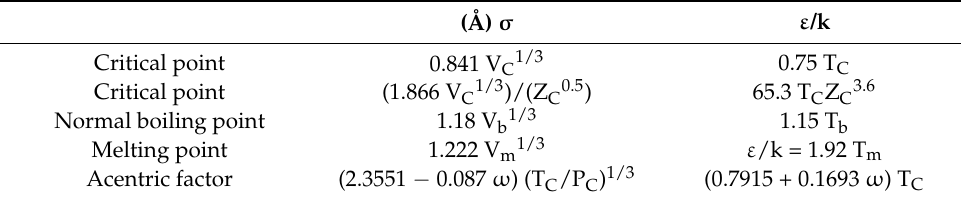
Table 4. Considered values for σ i and ε i [31].